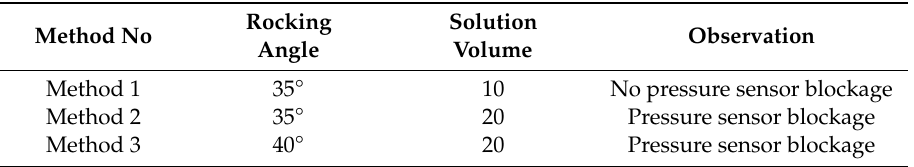
Table 1. Summary of the three attempted methods and di ff erent rocking angle and solution volume